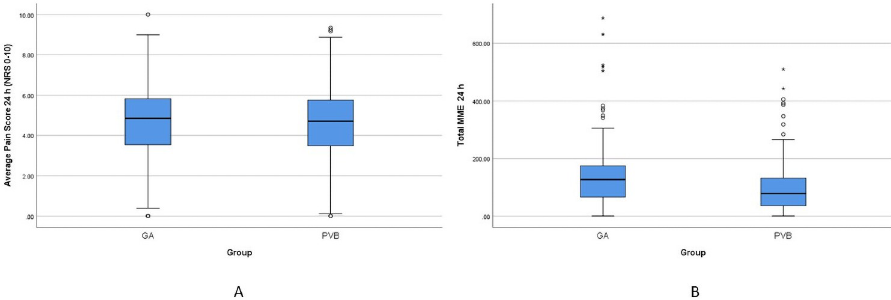
Fig 2. A. Average numeric rating scale (NRS) pain scores in the first 24 postoperative hours in the 2 groups. B. Opiod consumption in terms of oral morphine milligram equivalents (MME) at 24 hours in the 2 groups.